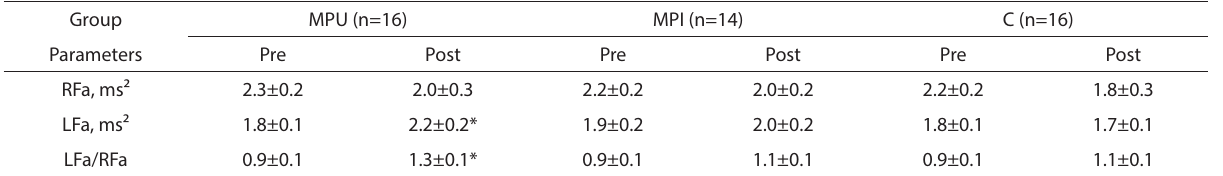
Table 2. HRV parameter changes after three interventions